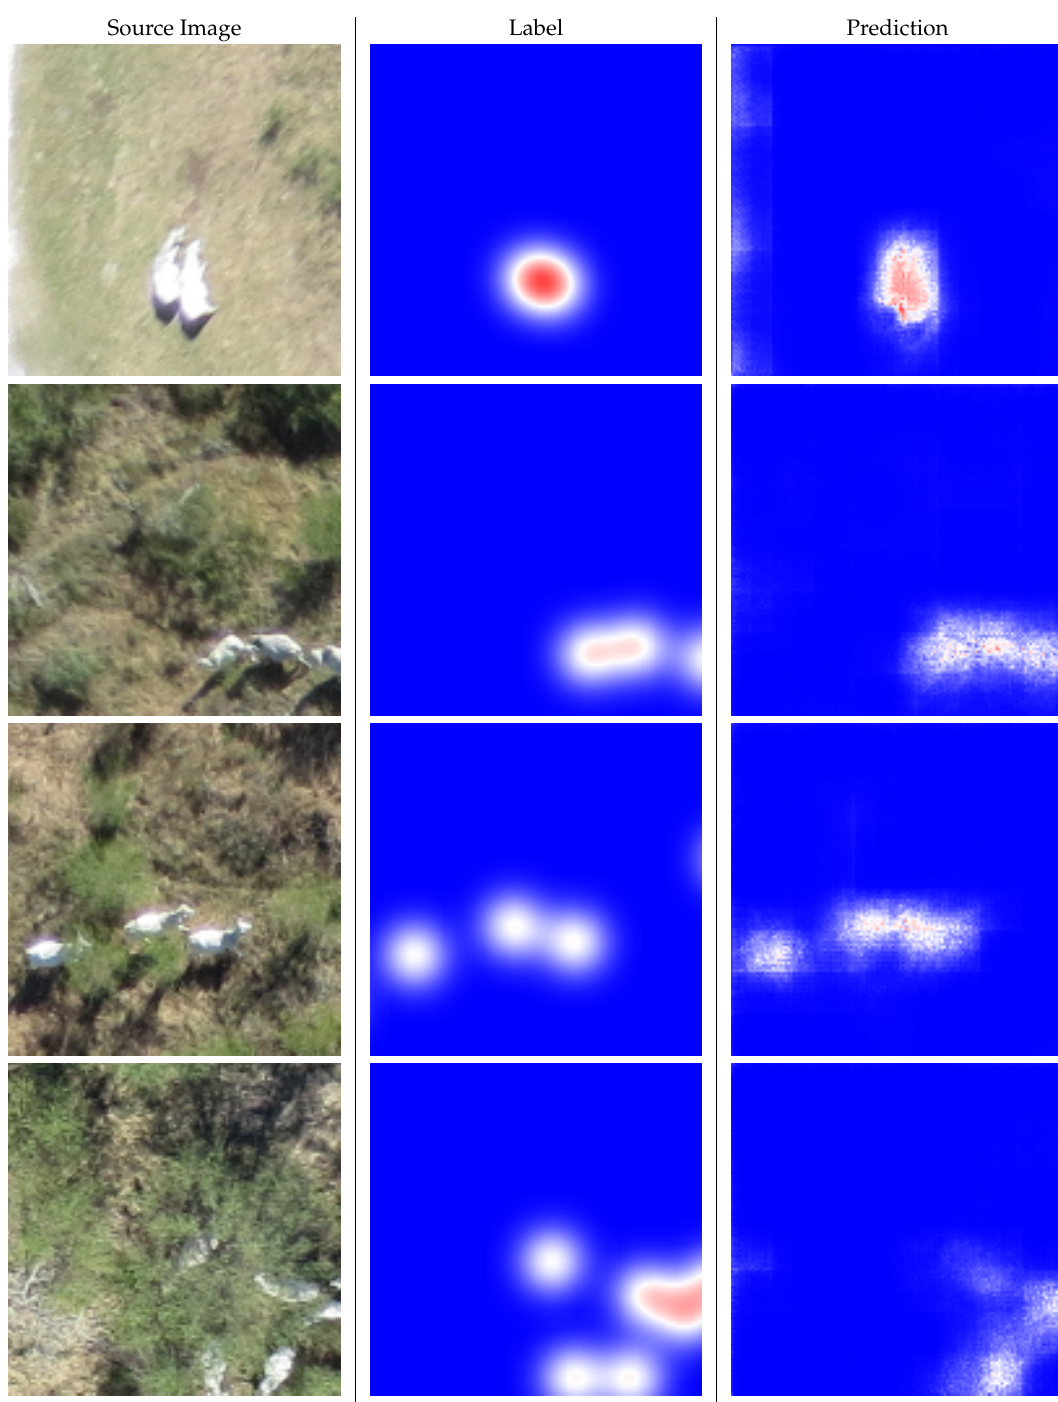
Figure 9. From left to right: Source Image regions, heat-map label, and heat-map